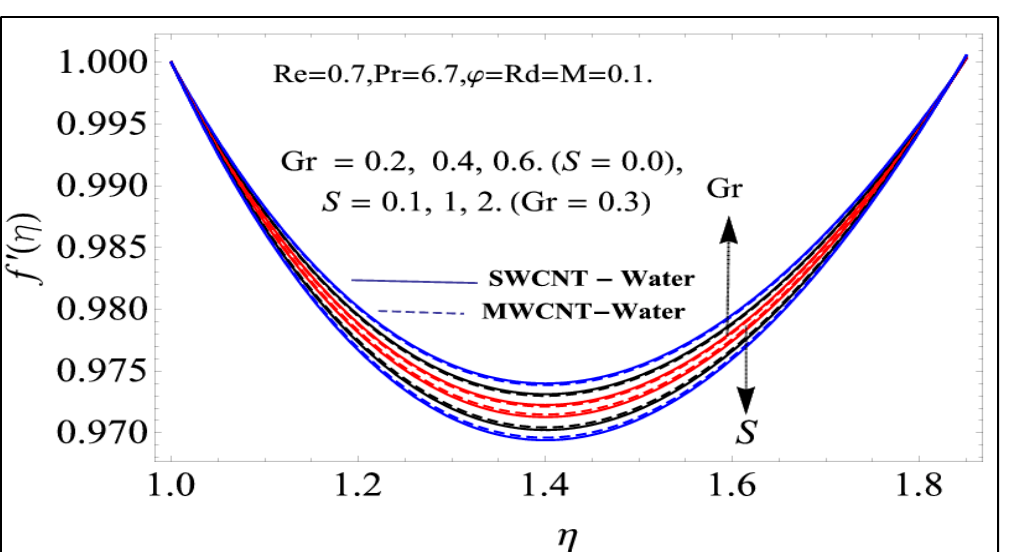
Figure 4. Impact of the nanoparticle volume fraction ϕ and thin film thickness parameter β on the velocity field.